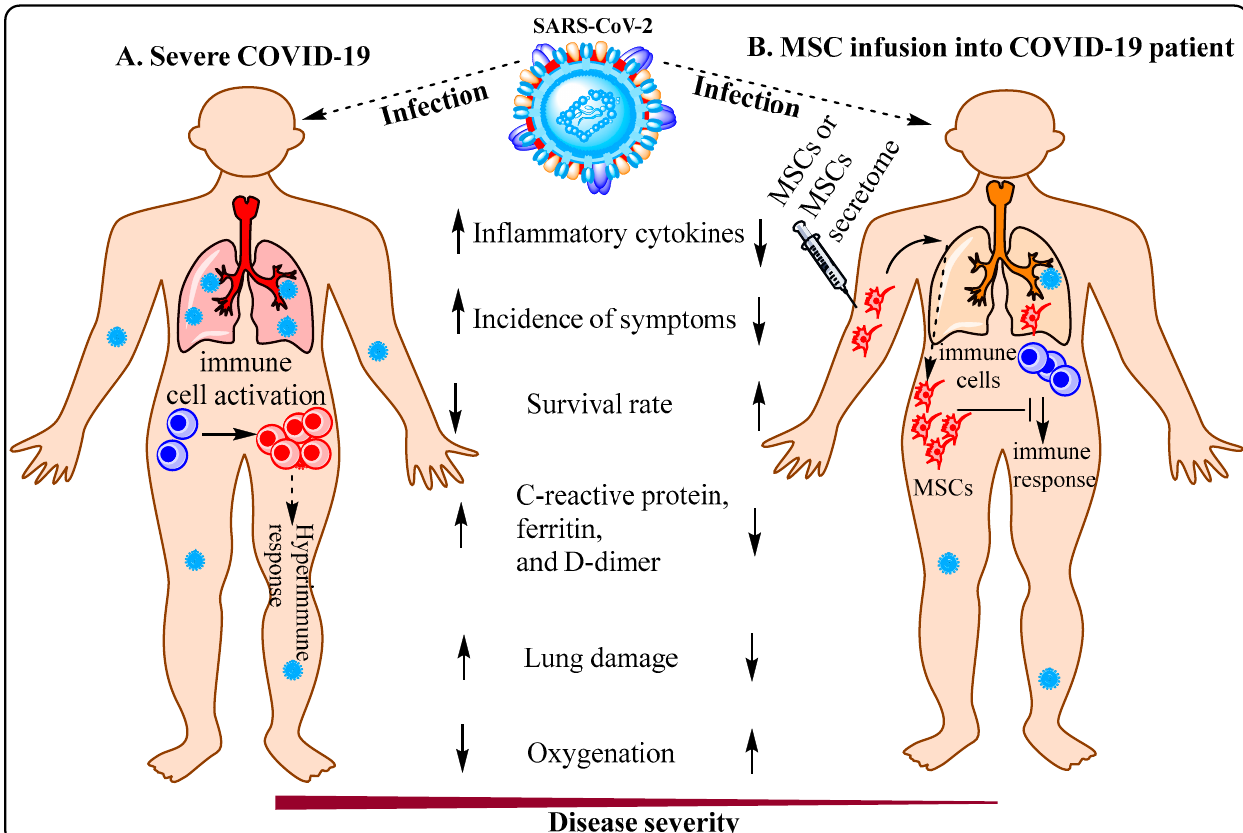
Figure 2. Therapeutic effects of mesenchymal stem cells in severe COVID-19 patients with ARDS. ( A ). Severe COVID-19 patients show enhanced incidence and persistence of symptoms (fever, tired- ness, diarrhea, shortness of breath, chest pain, disorientation), increased secretion of inflammatory cytokines and bioactive molecules (C-reactive protein, ferritin, and D-dimer), leading to substantial lung damage and, therefore, hypoxic condition. ( B ). MSCs and/or MSC secertome infusion in severe COVID-19 patients ameliorate disease-specific symptoms, reduce inflammation, restore lung damage and oxygenation, and thereby increase survival rate.